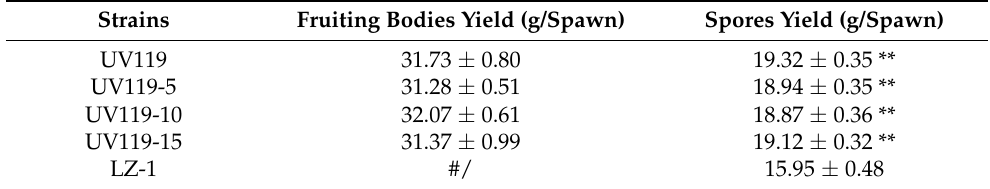
Figure 5. Fruiting of the 1st, 5th, 10th and 15th generations of the mutagenic strain UV119. ( A ): Fruiting situation of different generations of UV119; ( B ): collection of spores powder. Table 5. Spore and fruiting body unit output of different generation subcultures of UV119. Strains Fruiting Bodies Yield